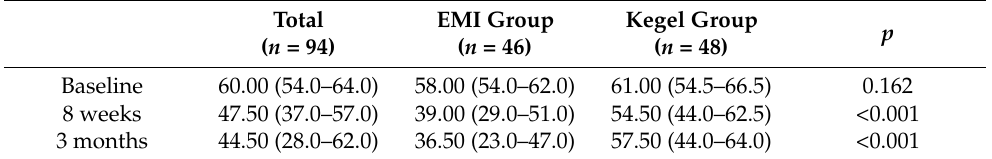
Table 5. Point values of the ICIQ-LUTSqol questionnaire with its respective interquartile range (25th and 75th percentile) in the study population and between the observed groups throughout the follow-up